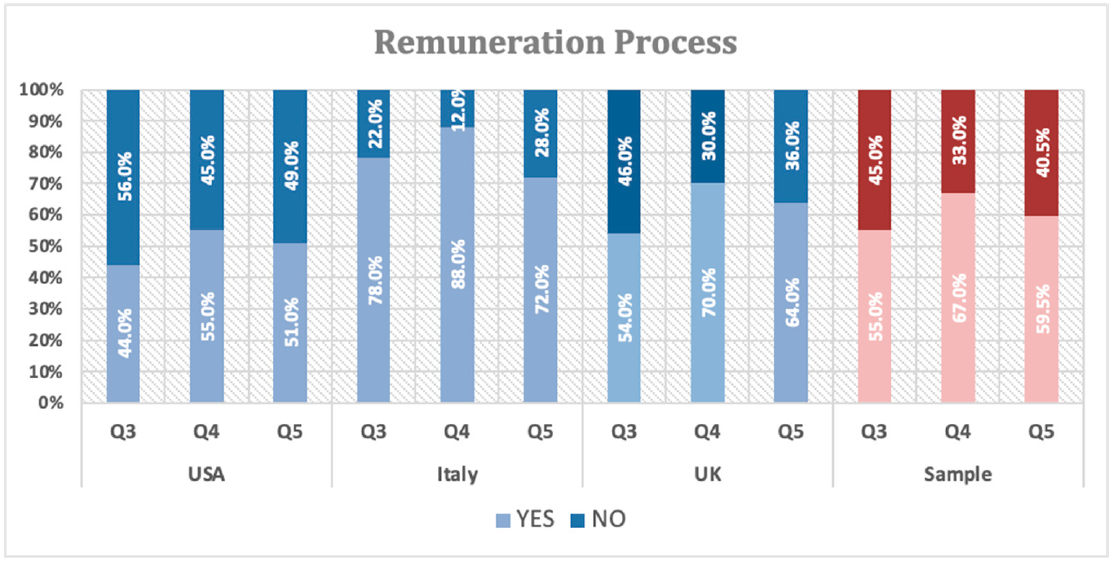
Figure 3. Answers to questions about the remuneration process (3, 4 and 5) by country of respond- ents.